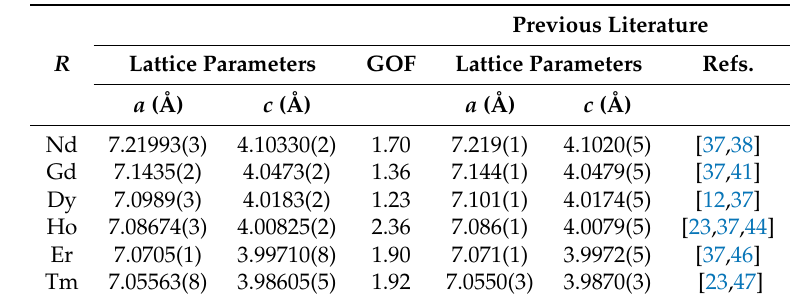
Table 2. Lattice parameters calculated from profile matching the powder X-ray diffraction patterns of the R B 4 samples to the P 4/ mbm tetragonal structure. The previously reported structural parameters quoted are taken from Refs. [37,47]. Additional references quoting structural parameters for each member of the series are included for